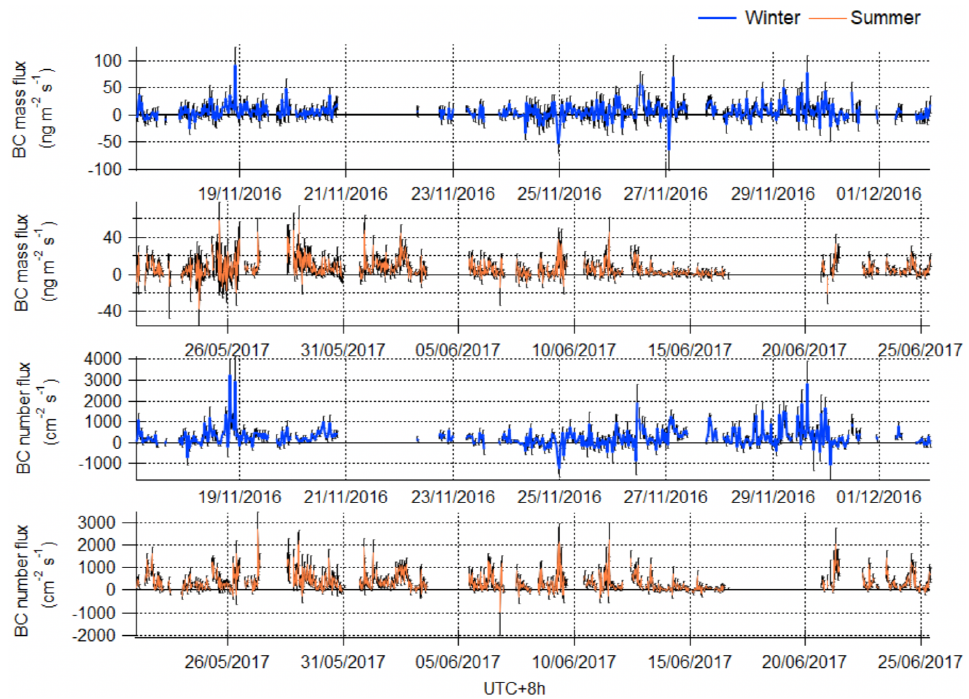
Figure 6. Time series of 30min averaged fluxes during winter (blue) and summer (orange) for mass and number fluxes, with random errors caused by associated uncertainties of the EC measurement system of this study (black